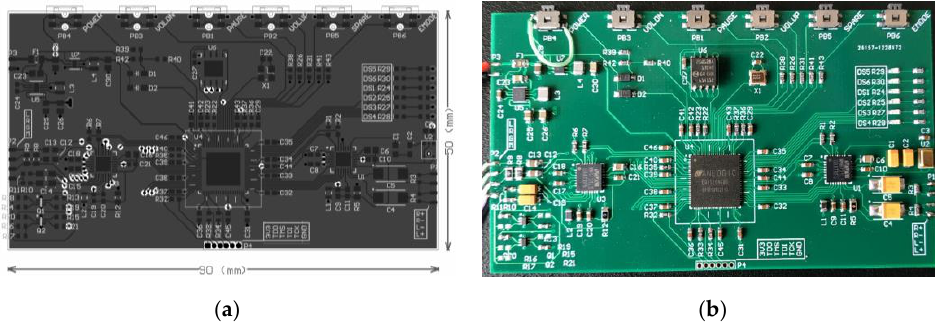
Figure 3. The voice encryption equipment’s PCB design ( a ) and physical diagram ( b ).